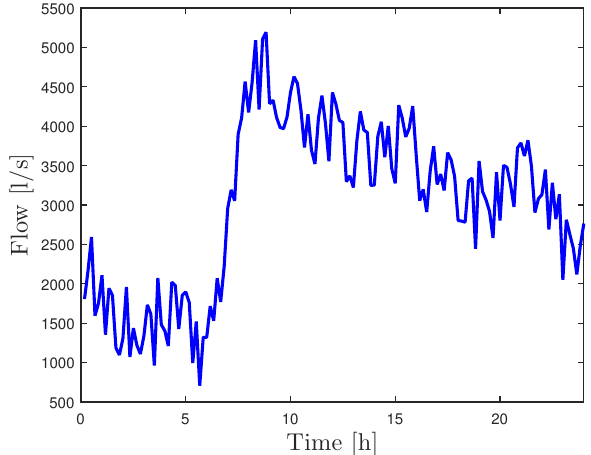
Figure 3. Example of a daily flow consumption in the simplified Hanoi topological